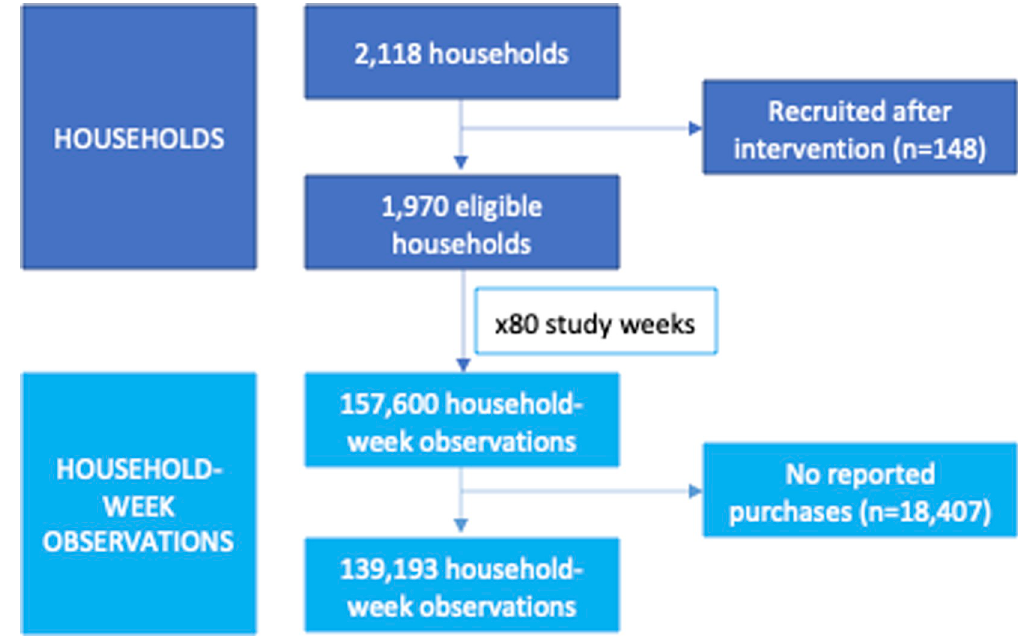
Fig 2. Eligibility and inclusion of households and household-week